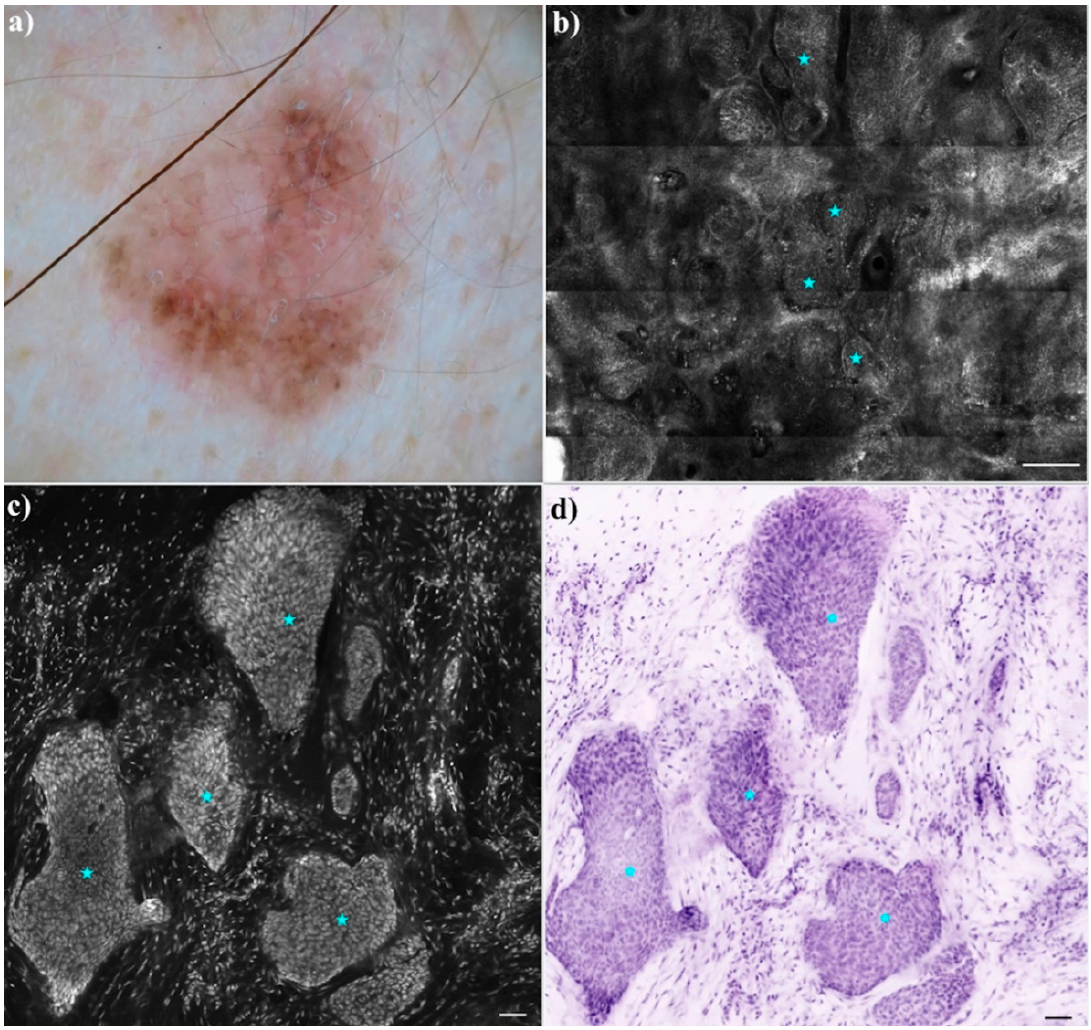
Figure 3. ( a ) Dermoscopy of a nodular basal cell carcinoma. ( b ) In vivo reflectance confocal microscopy showing tumor islands with palisading (blue arrows) and peripheral clefting in horizontal section. Scale bar 200 μ m. ( c ) High-resolution fluorescence confocal microscopy image showing basaloid islands (blue arrows) with peripheral palisading and clefting that corresponded to the ones seen on hematoxylin & eosin digitally stained ( d ). Scale bar 200 μ m.